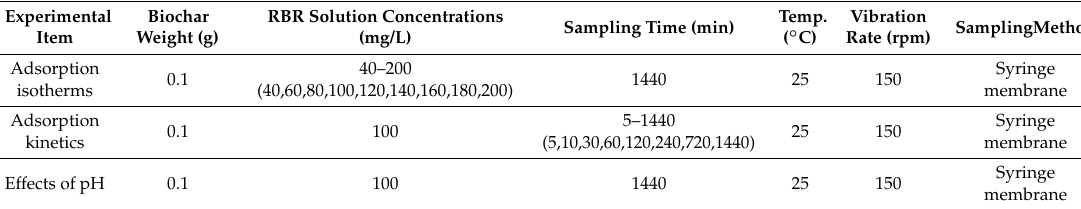
Table 1. The adsorption experimental runs and conditions.